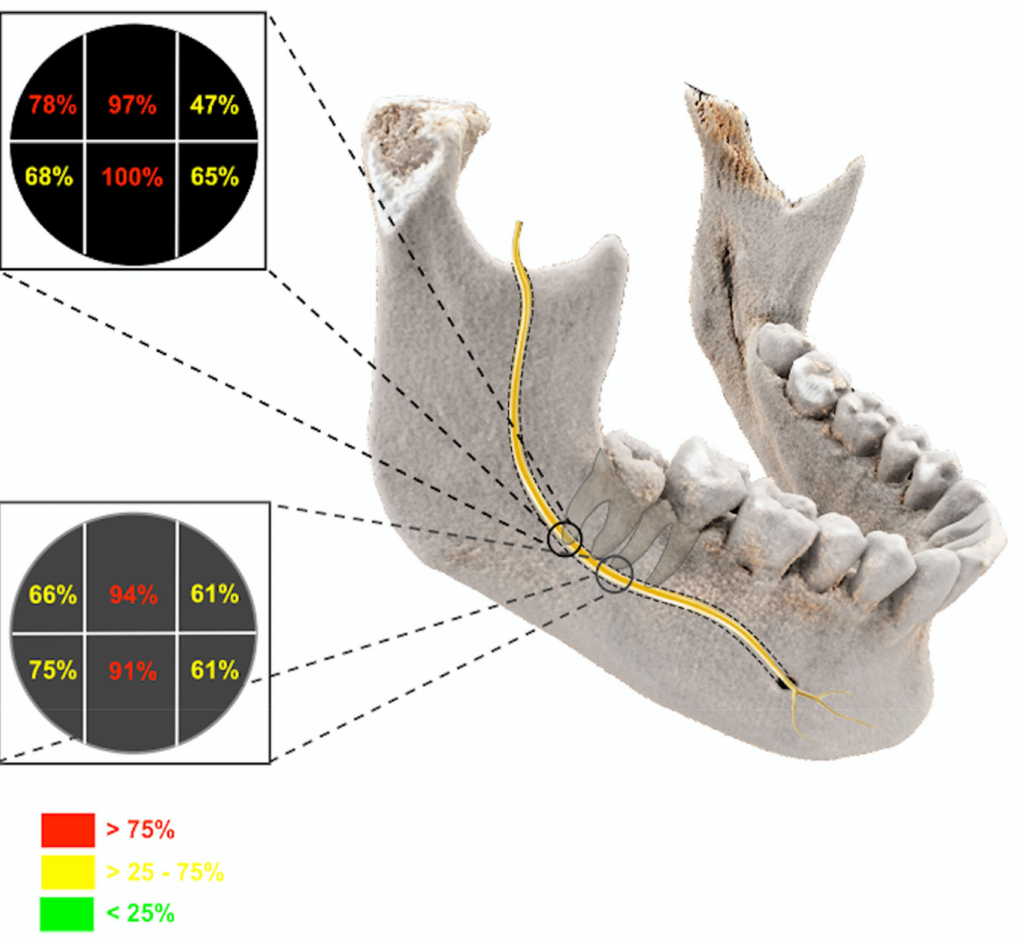
Figure 5. Photorealistic three-dimensional visualization of a study participant’s cone-beam computed tomography using cinematic rendering. The evaluation of the intraosseous position regardless of the positional relationship of the IAN in the reference images at the third and second molar is